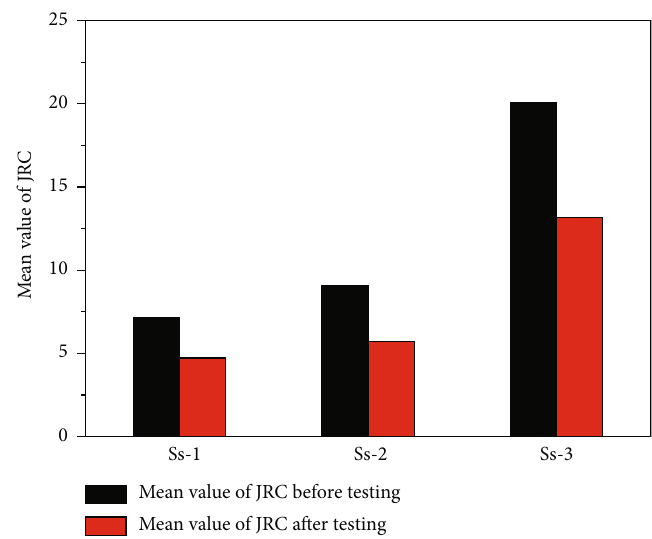
Figure 13: Mean value changes of JRC of samples Ss-1, Ss-2, and Ss-3 before and after testing under static stress.